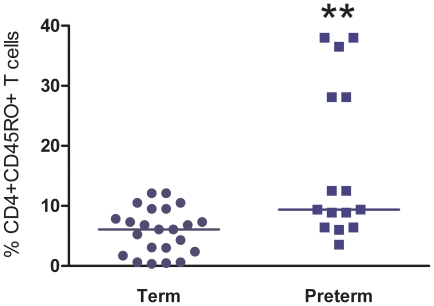
Preterm infants demonstrate enhanced memory T cell induction.Memory T cell frequency was compared between the term group (n = 23) and the preterm group (n = 15). Preterm neonates had an increased median percentage of memory CD4+ T cells (9.40%, IQR: 6.40, 28.10), CD45R0+/CD45RA-, compared to the median percentage of memory CD4+ T cells in term infants (6.10%, IQR: 2.37, 9.50) in term infants (P = 0.0032).